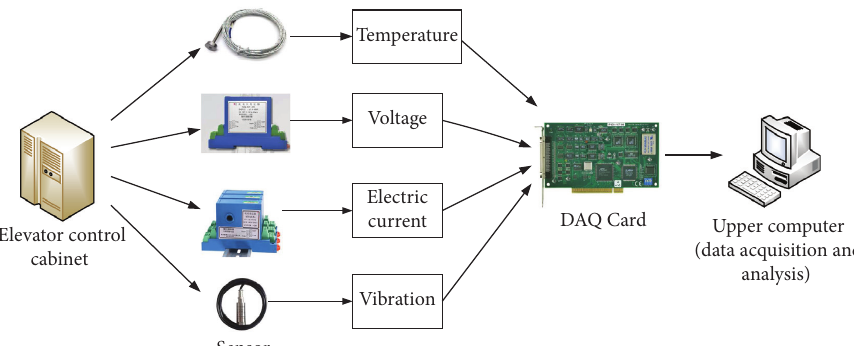
Figure 1: Schematic diagram of the condition monitoring system of elevator control transformer.